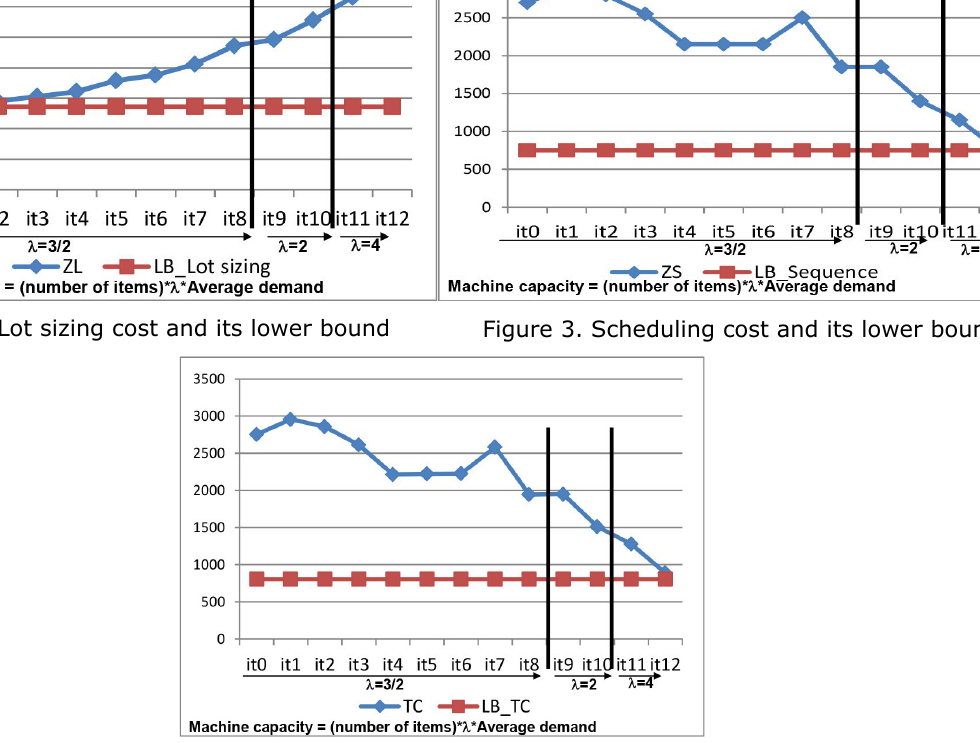
Figure 4. Total cost and its lower